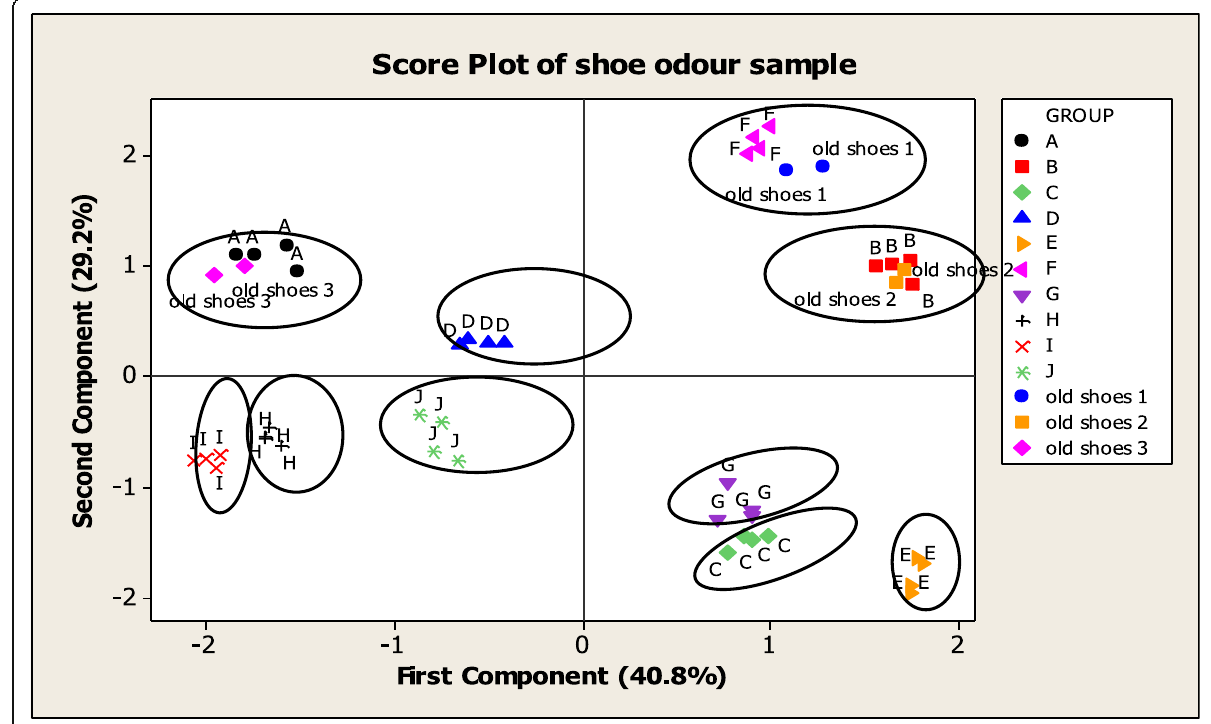
Fig. 6 Score plot of PC1 and PC2 for shoe odour